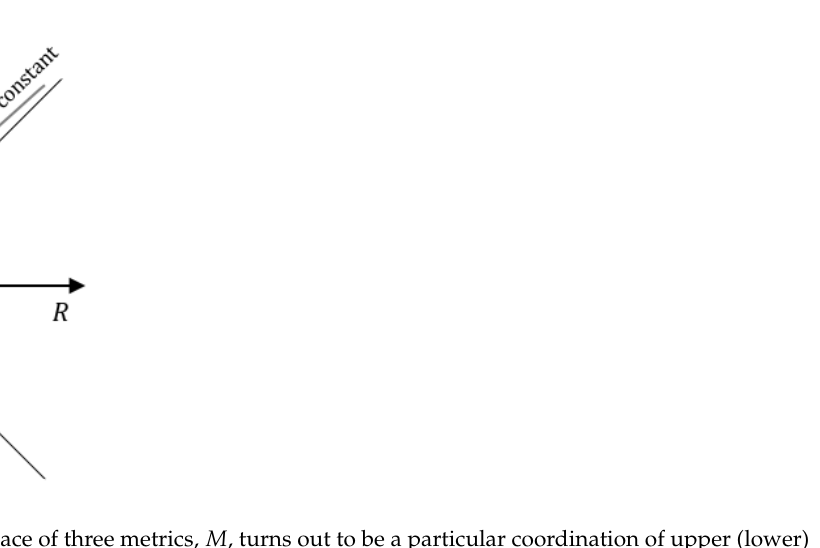
Figure 14. The space of three metrics, M , turns out to be a particular coordination of upper (lower) light cone of a 6-dimensional Minkowki space. Every point in the T , R plane is a four-sphere of unit radius. Lines of constant τ are lines of constant volume of the spatial sections of the spacetime (with different shapes). Lines of constant χ correspond to different volumes of the same shape (a scaling universe). Something similar occurs in the lower light cone, which would represent a time-reversed copy of the